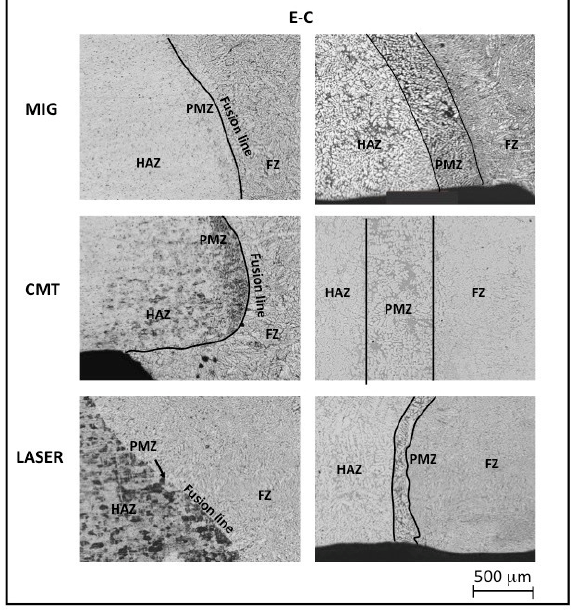
Figure 10. Macrostructures of the interface between the HAZ, PMZ, and FZ in the Extruded-Cast combination (E-C), Keller etch, 50×.